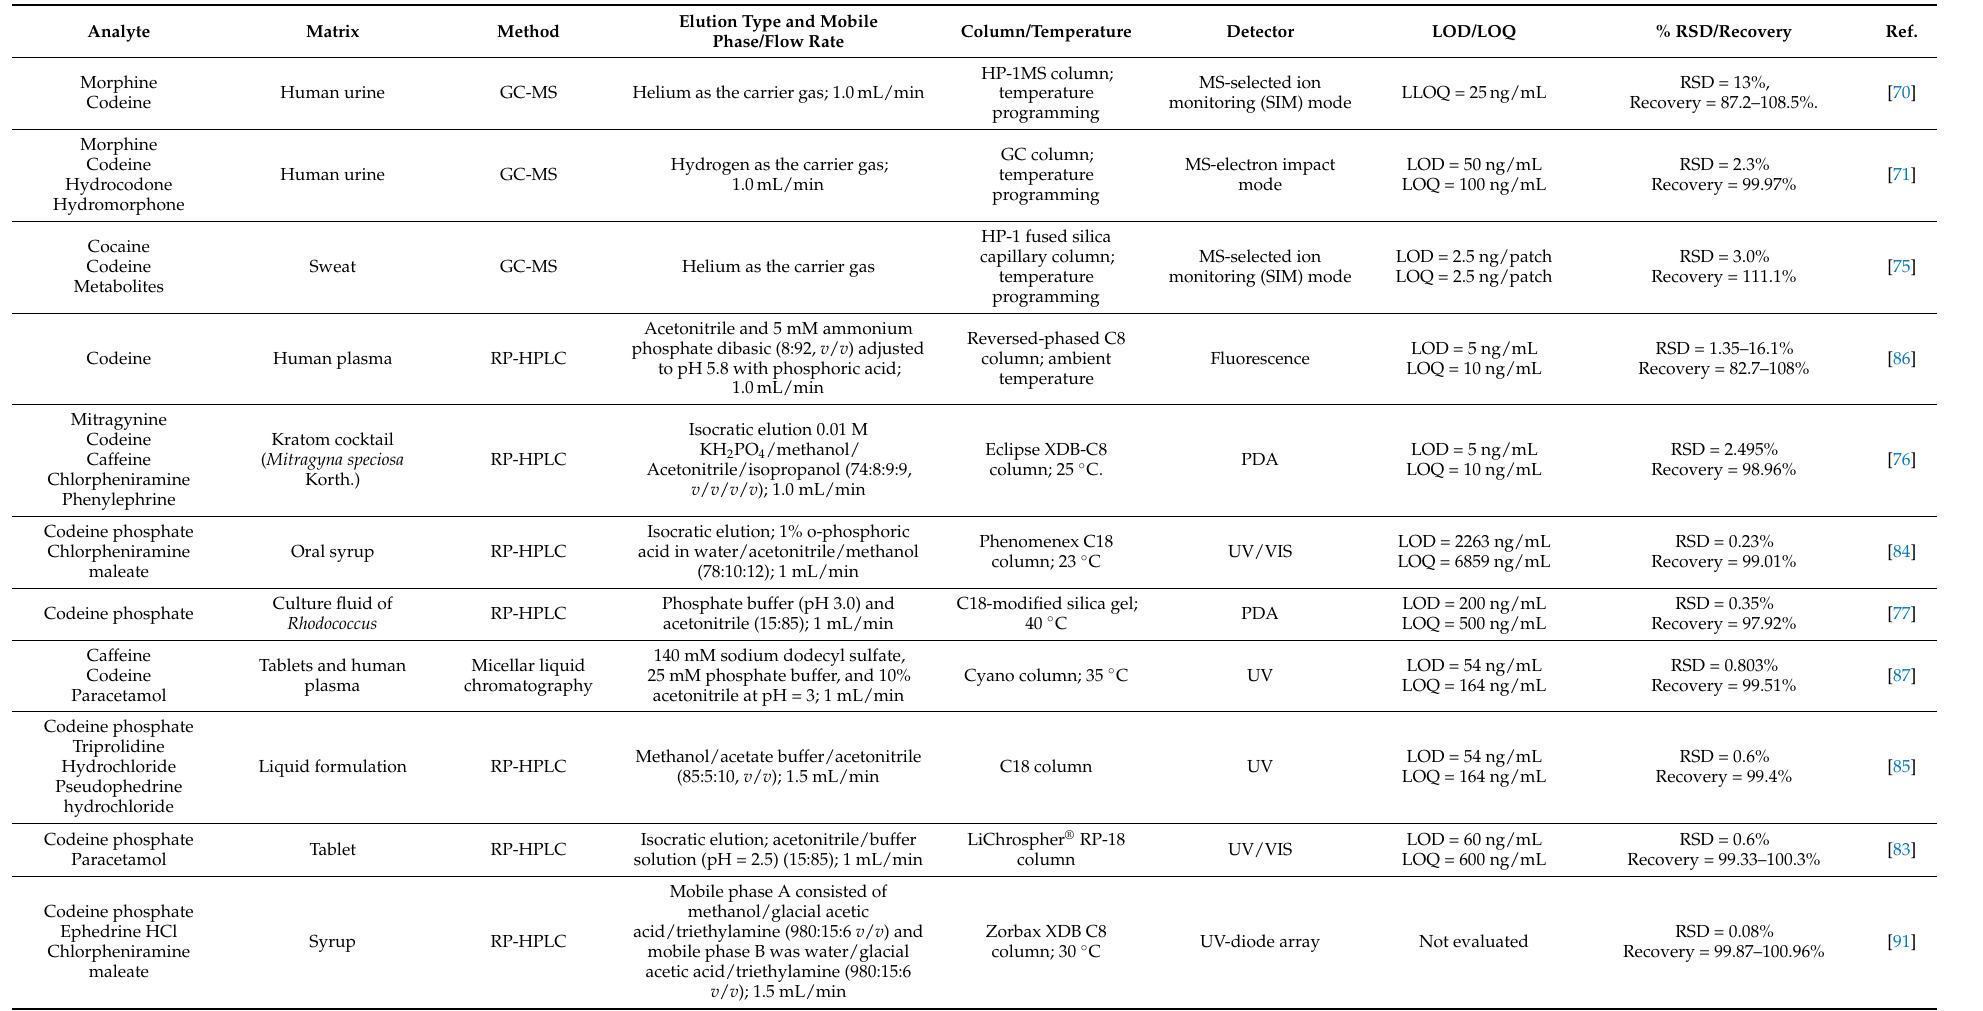
Table 4. Chromatographic system for codeine